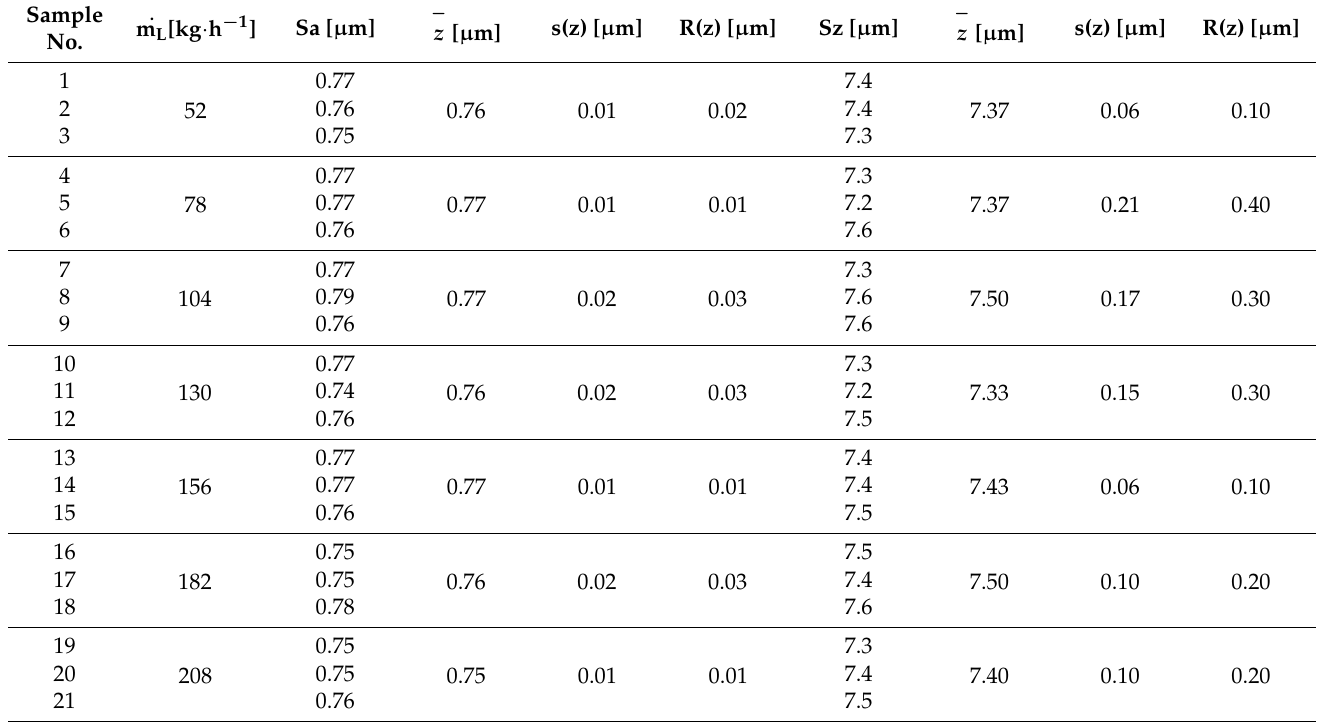
Table 5. Results of Sa and Sz measurements of X5CrNi18-10 steel specimens after removal of paint coating (p w = 20 MPa, l 2 = 250 mm, κ = 90 ◦